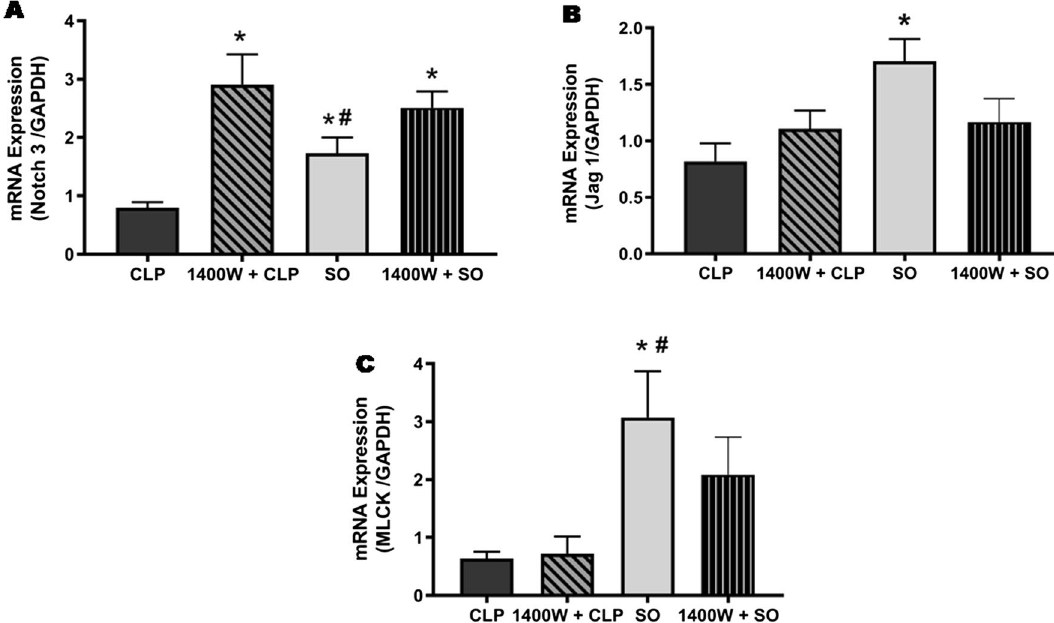
Figure 10. Role of iNOS/NO pathway in sepsis-induced attenuation of Notch signaling. Bar diagrams showing the effect of in vivo treatment with 1400 W, a selective inhibitor of inducible nitric oxide synthase (iNOS), on sepsis-induced attenuation of mRNA expression of Notch3 receptor ( A ), Jag1 ligand ( B ) and MLCK ( C ) genes in mouse aorta. SO sham-operated, CLP sepsis. Data are presented as mean ± SEM. Vertical bars represent SEM; n = 4–7. Data were analyzed by one-way ANOVA followed by Tukey’s post-hoc test. * p < 0.05 vs. CLP; # p < 0.05 vs. 1400 W +